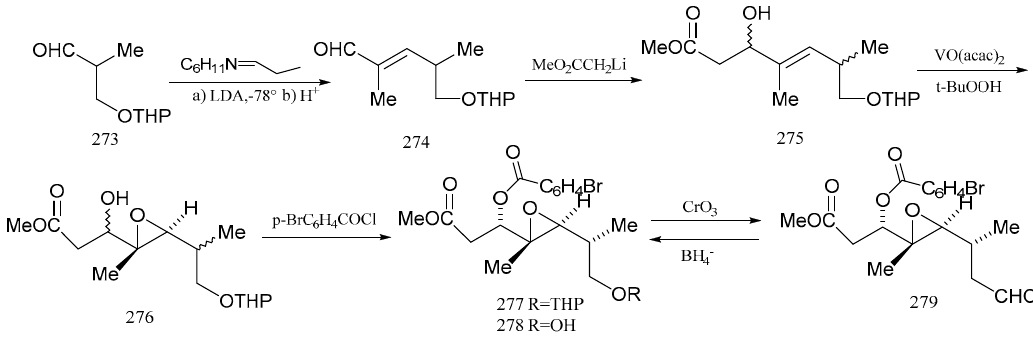
Figure 9. The synthetic by-products of the northern fragments of maytansine.